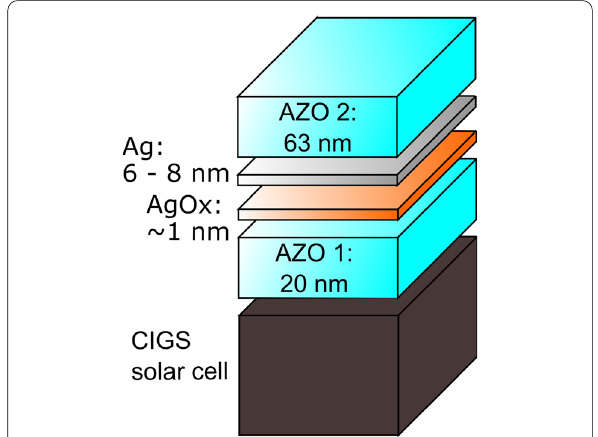
Fig. 1 Schematic layer stack of OWLMO electrode on the CIGS solar cell. The conductivity and transparency of the intermediate Ag layer can be improved on with a wetting